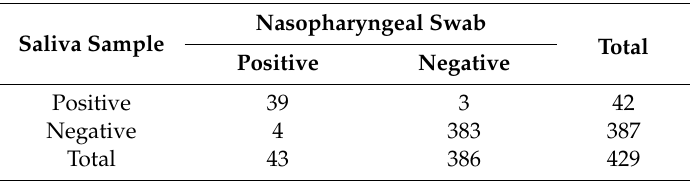
Table 1. Results of SARS-CoV-2 detection in paired nasopharyngeal swab and saliva specimens from individuals who presented to an outpatient testing center.